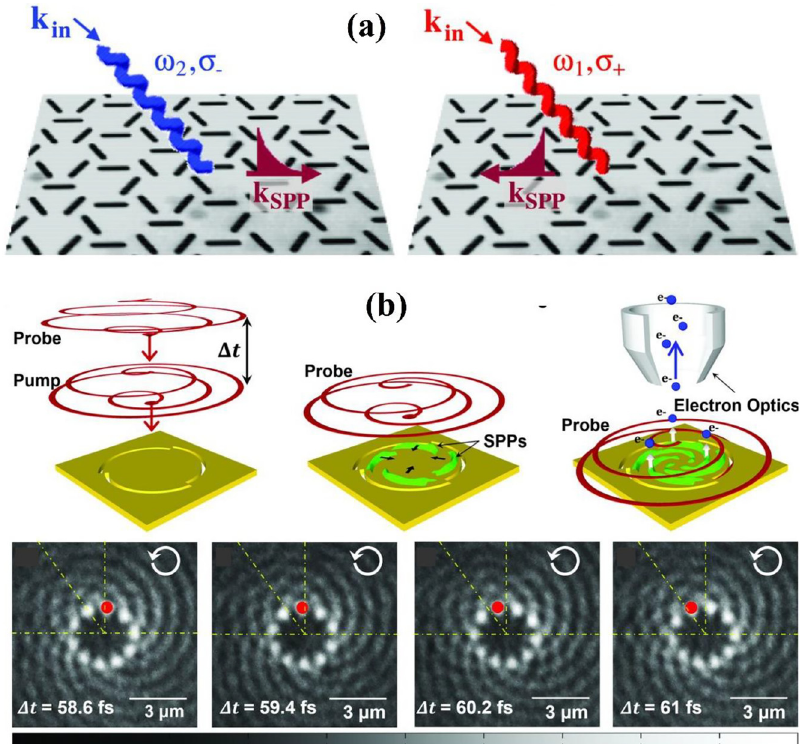
Figure 7: PSHE in metal metasurface